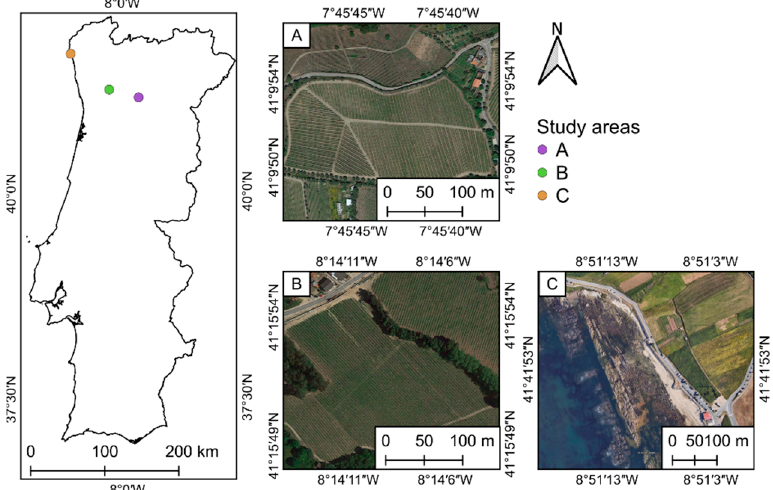
Figure 13. Location of the Portuguese study areas: ( A ) 1.5 ha vineyard parcel, belonging to Quinta do Vallado, Peso da Régua, Portugal; ( B ) 2 ha vineyard parcel, in Lousada, Porto, Portugal; and ( C ) 5 ha coastal area, located in Viana do Castelo, Portugal. Images from Google Earth (accessed on